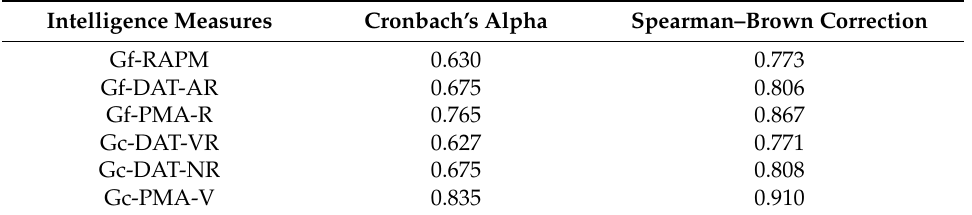
Figure 1. Timeline of the research program described in the present article. Table 1. Reliability (Cronbach’s alpha values) for all intelligence measures. RAPM = Raven Advanced Progressive Matrices, DAT-AR = abstract reasoning subtest from the Differential Aptitude Test, PMA-R = inductive reasoning subtest from the Primary Mental Abilities Battery, DAT-VR = verbal reasoning subtest from the DAT, DAT-NR = numerical reasoning subtest from the DAT, PMA-V = vocabulary subtest from the PMA. Gf = fluid intelligence, Gc = crystallized intelligence.